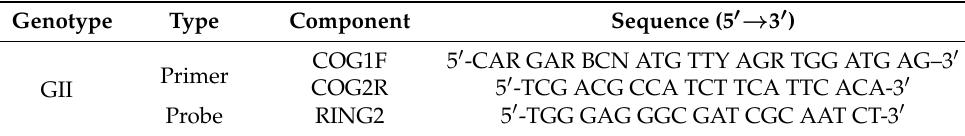
Table 1. Sequence of primers and probe for RT-qPCR to quantitate HNoV GII.4. Genotype Type Component Sequence (5 (cid:48) → 3 (cid:48) ) Primer GII